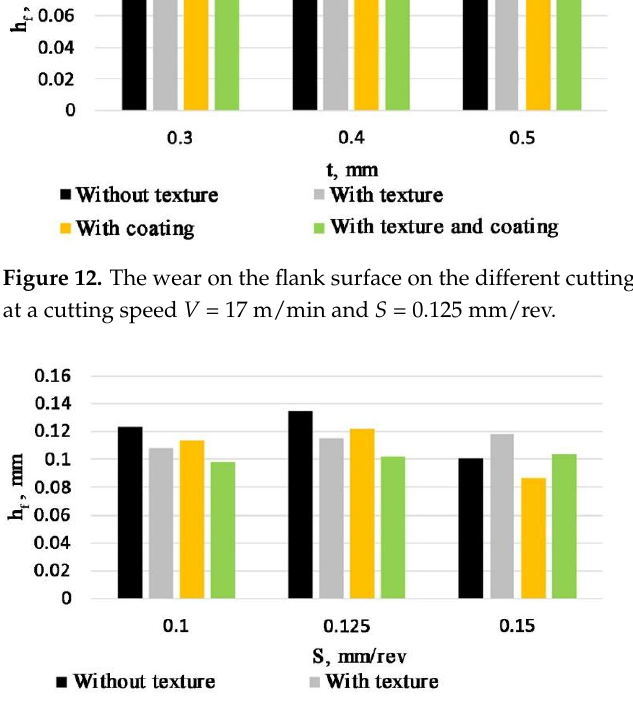
Table 1. Values of the studied processing parameters were obtained as a result of experiments for the original and textured tool.